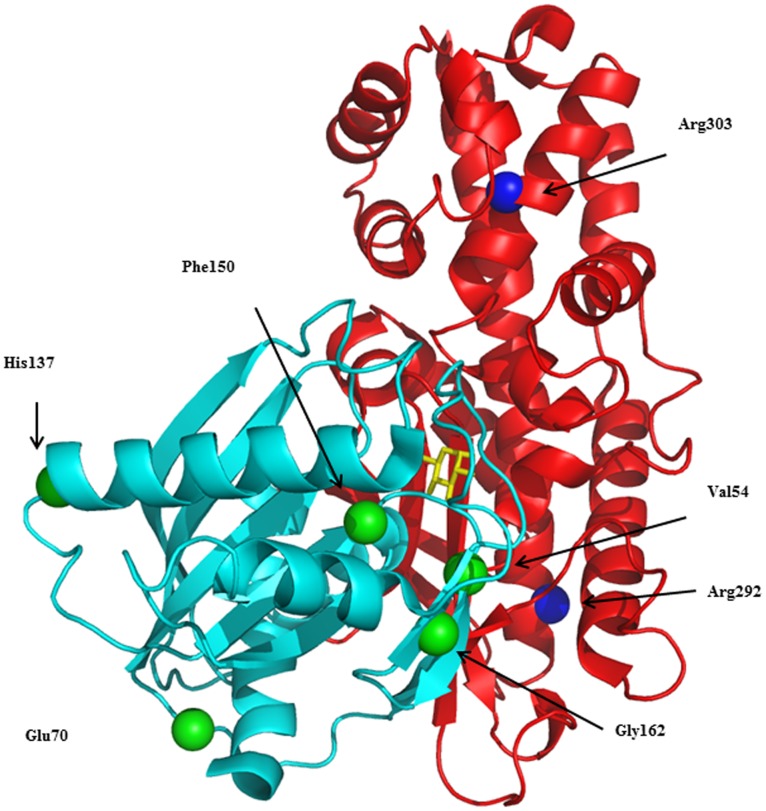
Distribution of the selected GCK mutations.The structure of GCK in the active closed form is shown (PDB code: 1v4s); the small and large domains are drawn in cyan and red, respectively; glucose appears as a yellow stick. Mutation sites are shown as green or blue spheres.